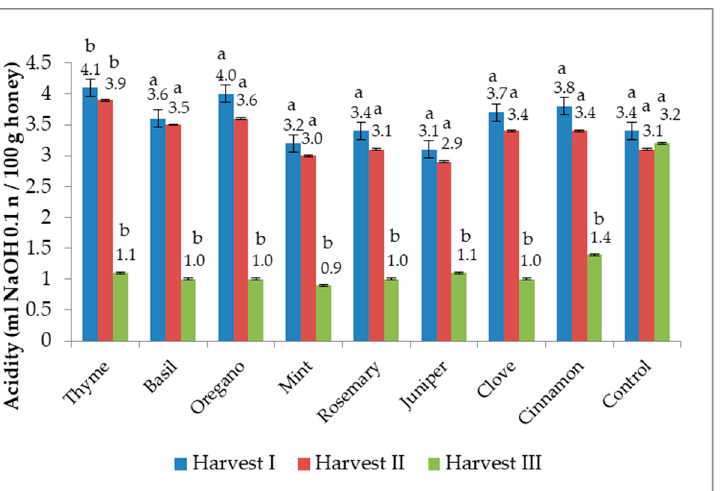
Figure 4. The acidity of the samples before (Harvest I), after (Harvest II) the use of EOs in the sup- plementary feed of bee families, respectively after the first harvest (rapeseed) (Harvest III). Different letters between control and samples indicate significant differences ( p < 0.05) among these values according to the t -test .